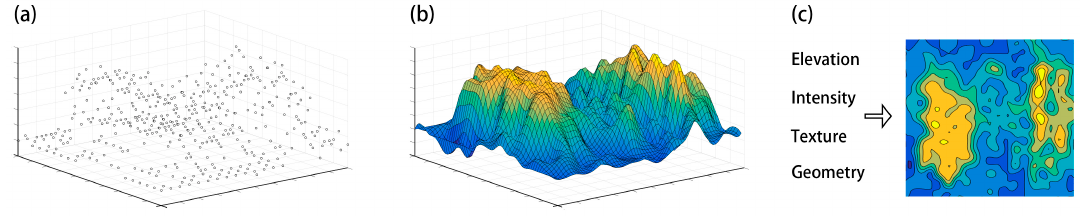
Figure 4. The schematic diagram of segmentation and classification-based DTM generation method. ( a ) Raw Lidar points; ( b ) Raster images produced using raw Lidar points; ( c ) After-image segmentation, unclassified segments are categorized into different land cover types by employing a diversity of features.